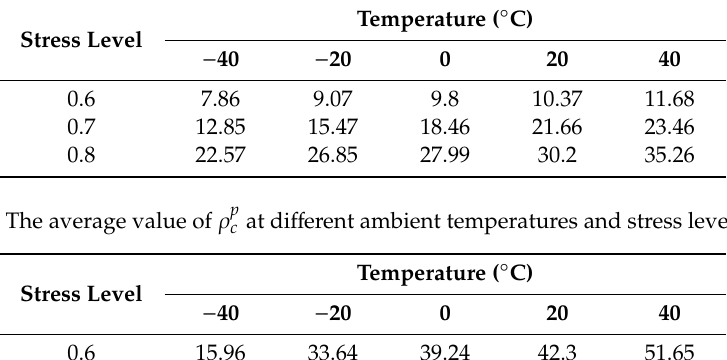
Table 12. The average value of ρ p